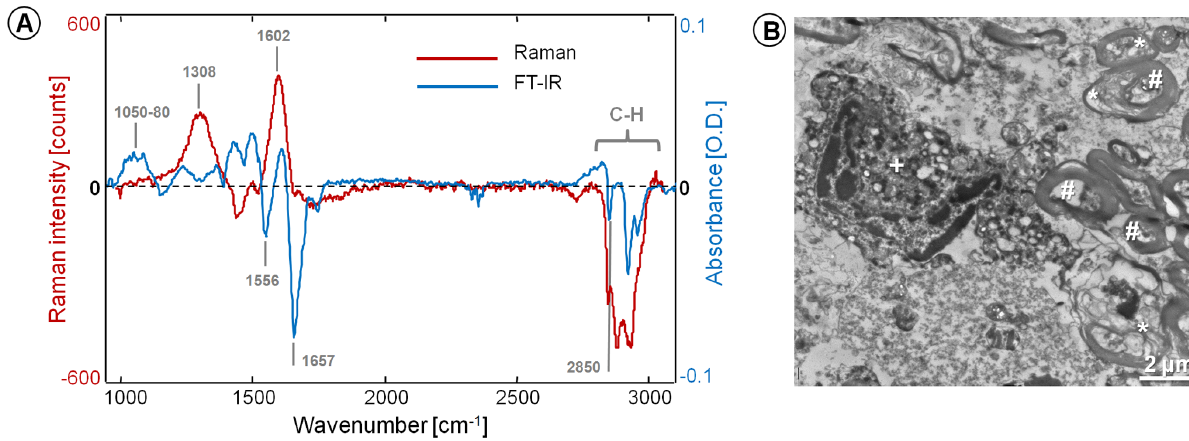
Figure 6. Characterization of tissue alterations connected to the irradiation-induced fluorescence. A : Raman and FT-IR spectra of an irradiated mouse brain cortex showing increased endogenous fluorescence. The spectra were obtained by subtraction of the not irradiated tissue spectrum from the irradiated one. The most pronounced positive and negative bands are labeled and discussed in the text. B : Transmission electron microscopy of an irradiated sample of human brain tissue (white matter), showing partially destroyed myelin sheaths (*), a partly damaged nucleus ( + ) and preserved axons ( # ).